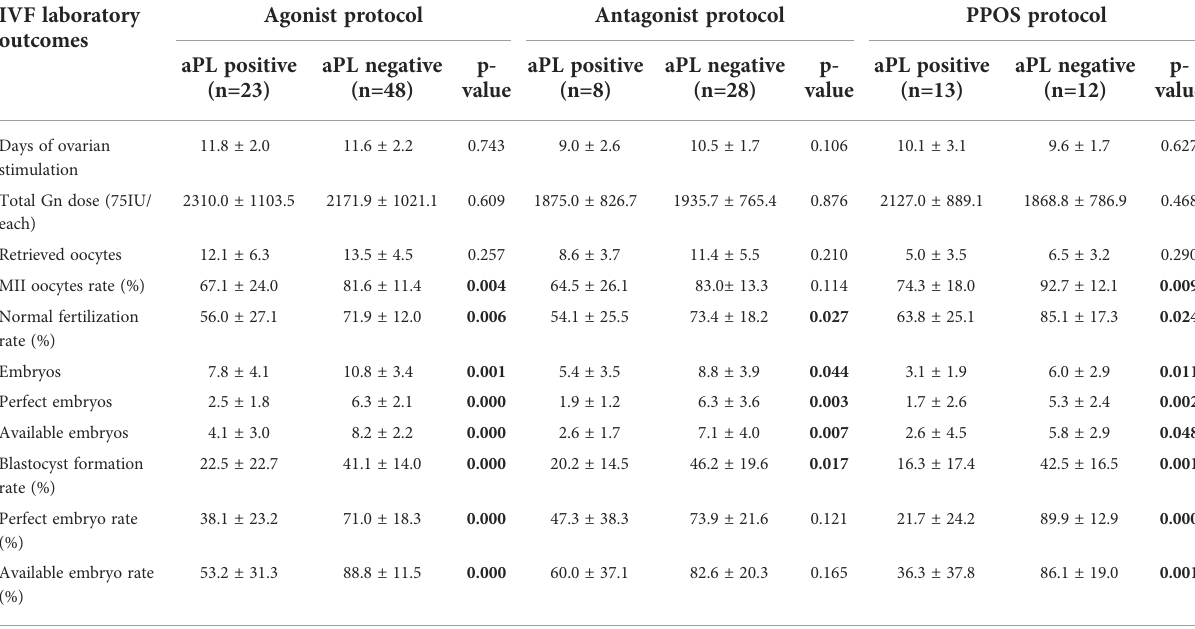
TABLE 2 Reproductive outcomes of IVF cycles in women with tubal etiology infertility with and without